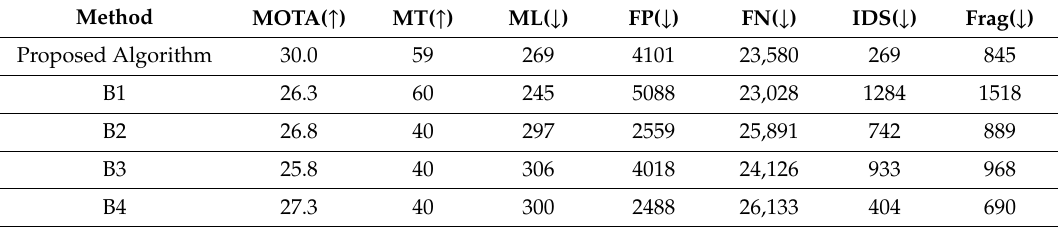
Table 2. Performance of our method when di ff erent components are